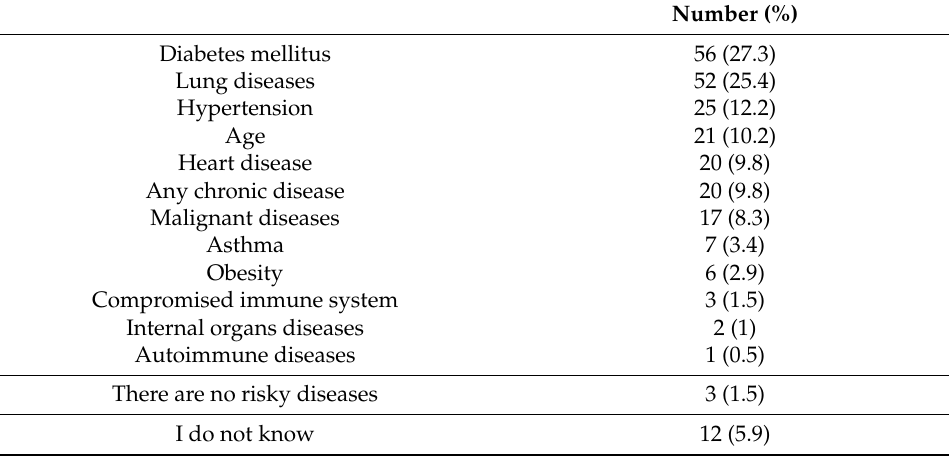
Table 5. High-risk diseases for